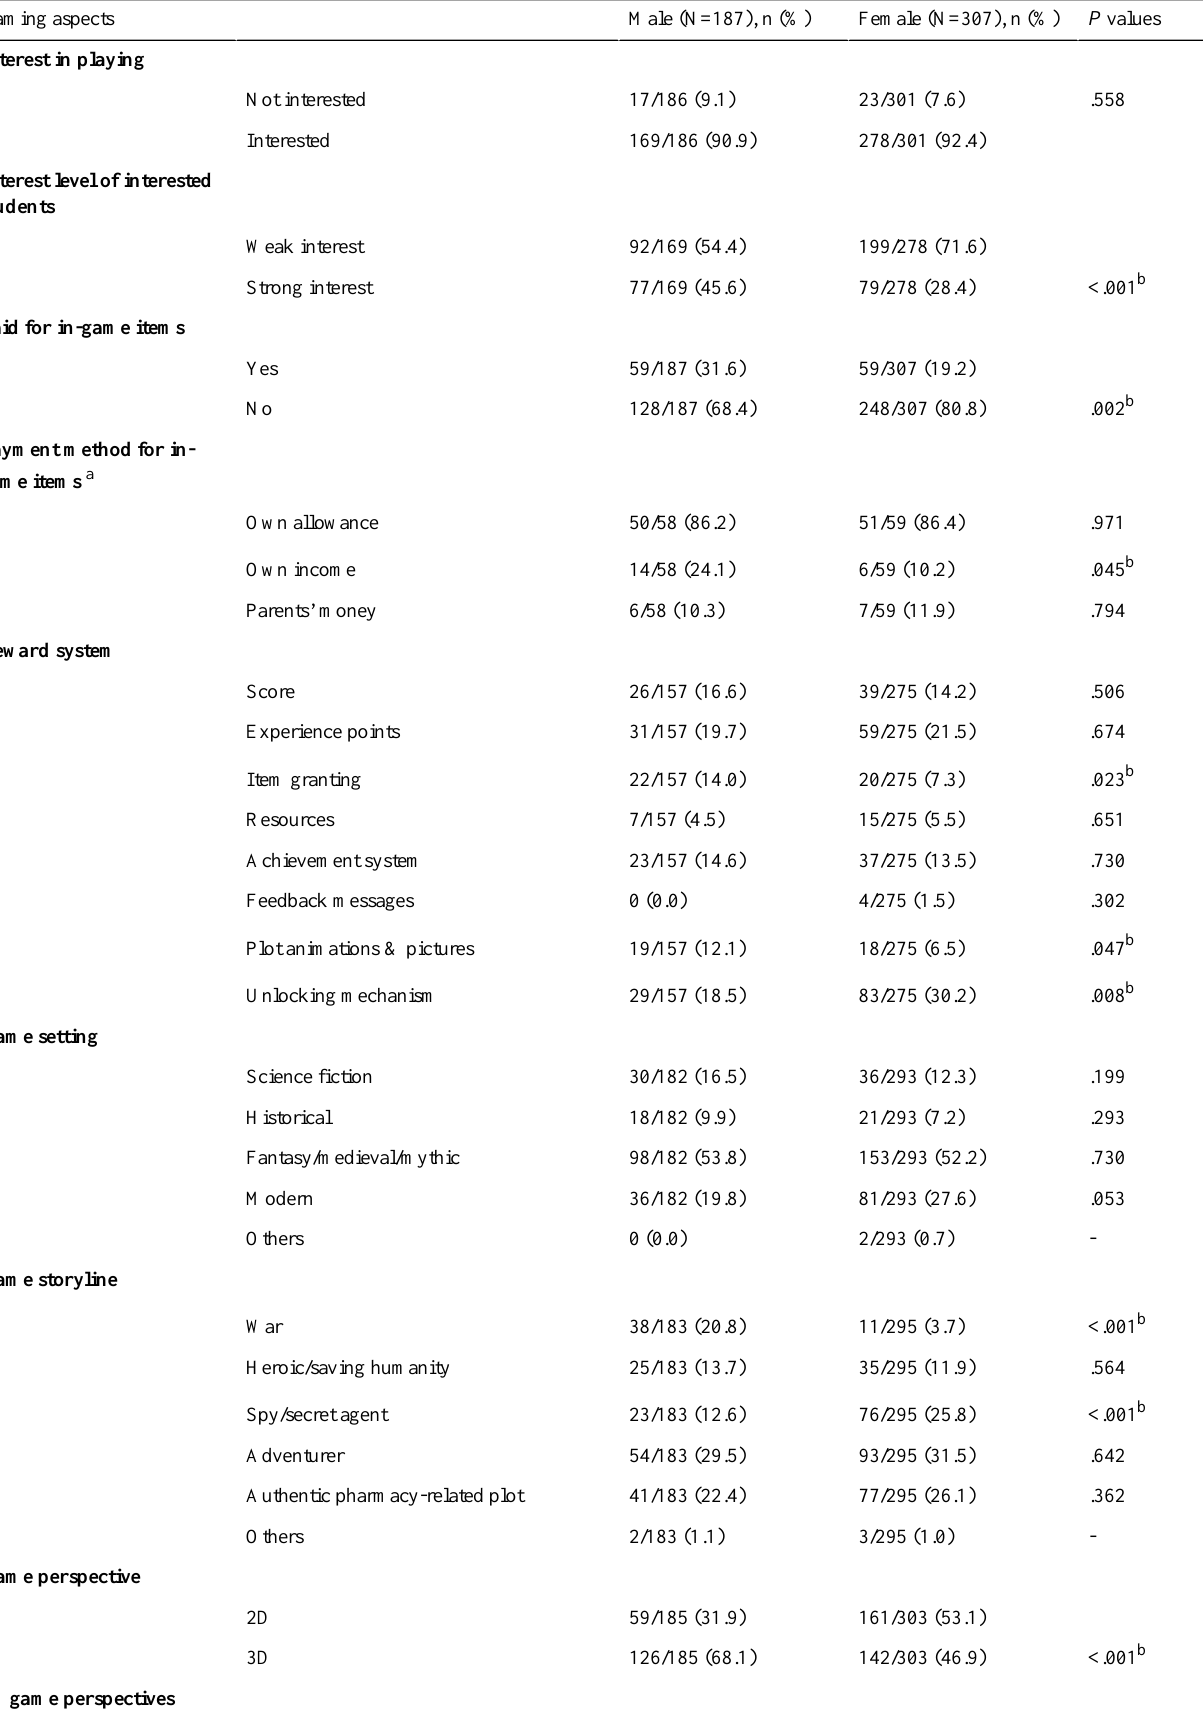
Table 2. Comparison of gaming aspects by